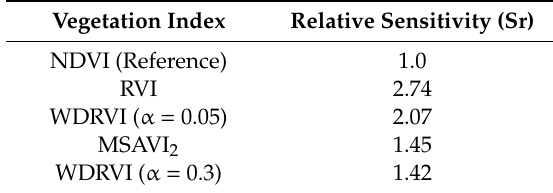
Table 3. Relative sensitivity (Sr) of indices with respect to LAI, with NDVI used as the